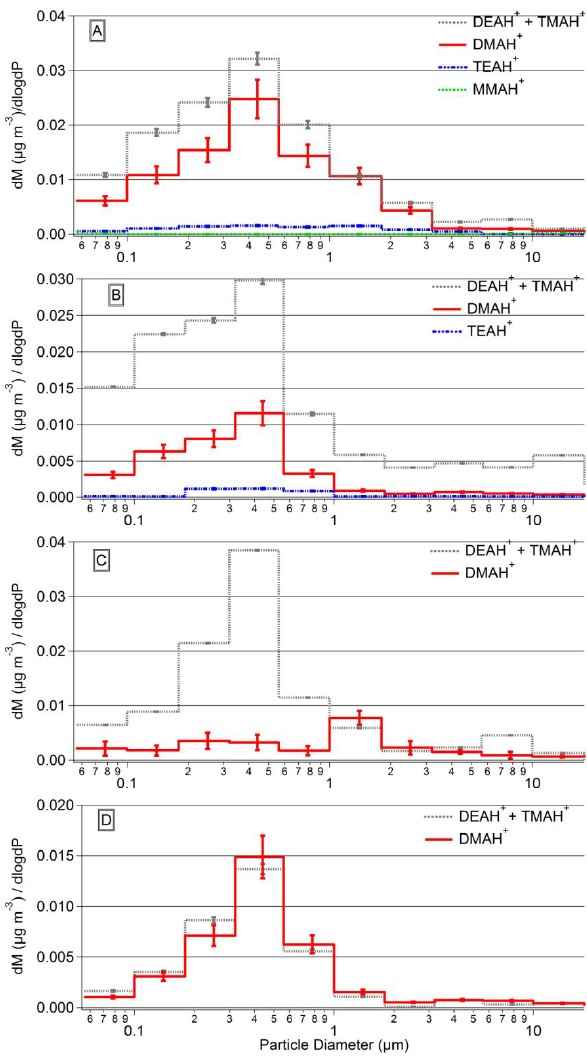
Figure 4. Amine mass distributions as a function of particle diameter for (A) Sample 4 collected in Dorset, (B) Sample 3 collected in Toronto (C) Sample 8 collected in Lambton Shores, and (D) Sample 1 collected in Toronto.